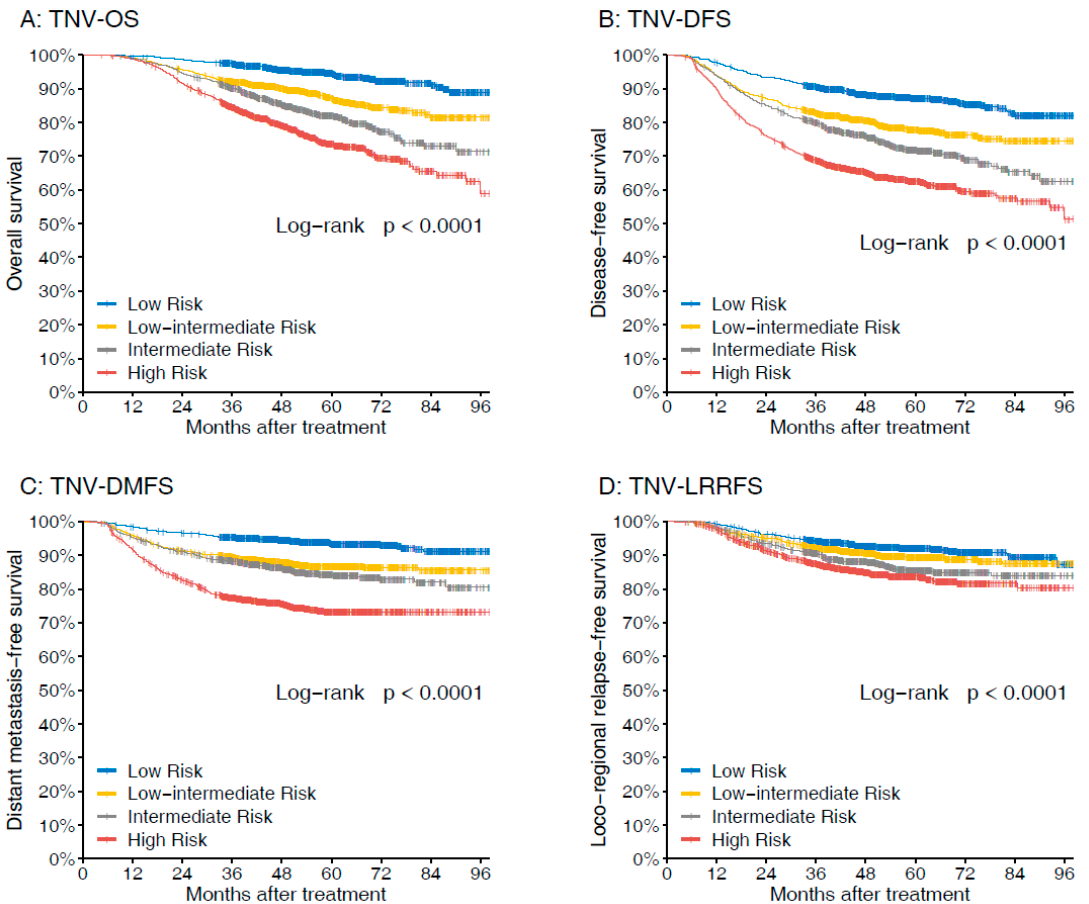
Figure 3. Comparison of the survival rates of di ff erent TNV groups with regard to ( A ) overall survival, ( B ) disease-free survival, ( C ) distant metastasis–free survival, and ( D ) loco-regional relapse-free survival.